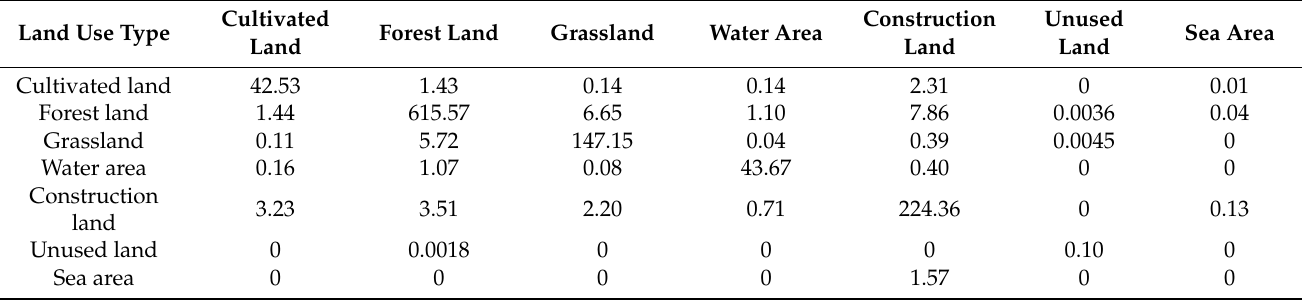
Table 7. Land use conversion matrix, 2010–2020 (km 2